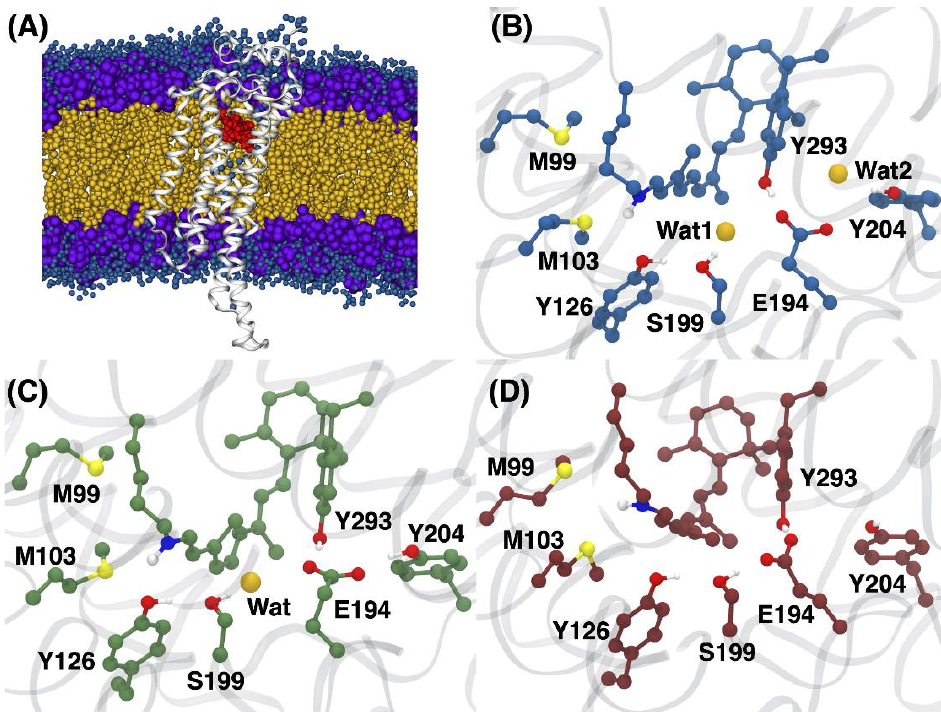
Figure 3. ( A ) JSR1 protein embedded in a membrane following the production procedure outlined